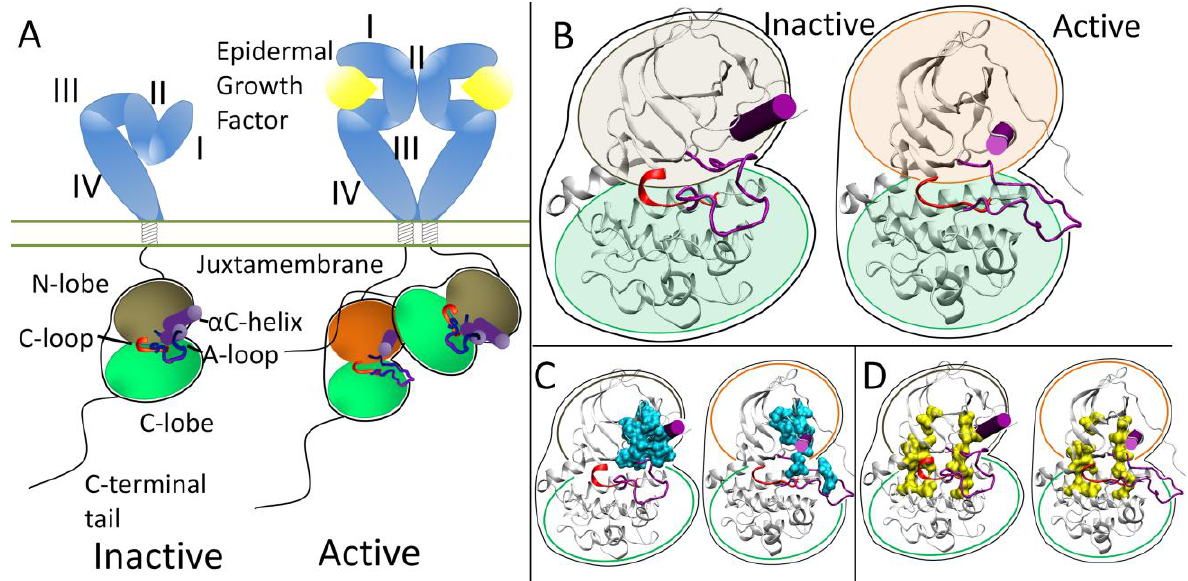
Figure 1. ( A ) Activation scheme for the ErbB family. The inactive kinase (brown N-lobe) is auto-inhibited through the A-loop and αC-helix (purple). Introduction of the asymmetric dimer interface rotates the αC-helix to the active state (orange N-lobe). ( B ) Enhanced view of the inactive and active kinase domains. ( C ) Hydrophobic core (cyan) in the inactive and active conformations. ( D ) C-spine (left yellow spine) and R-spine (right yellow spine) in the inactive and active